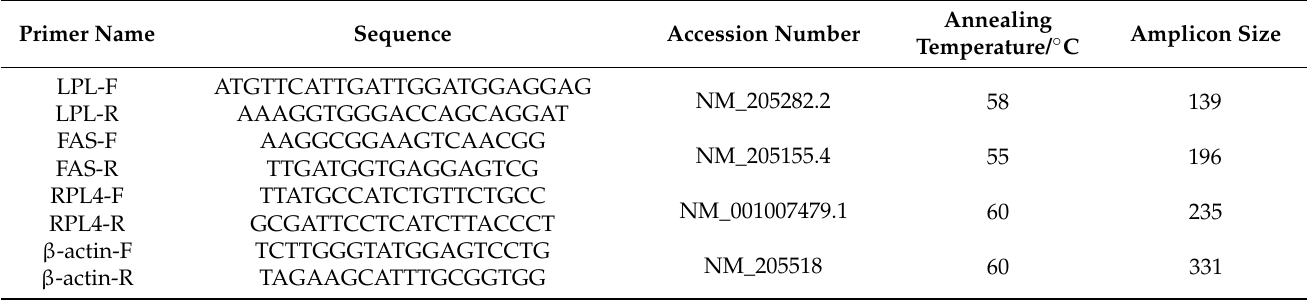
Table 1. List of RT-qPCR primers used in this